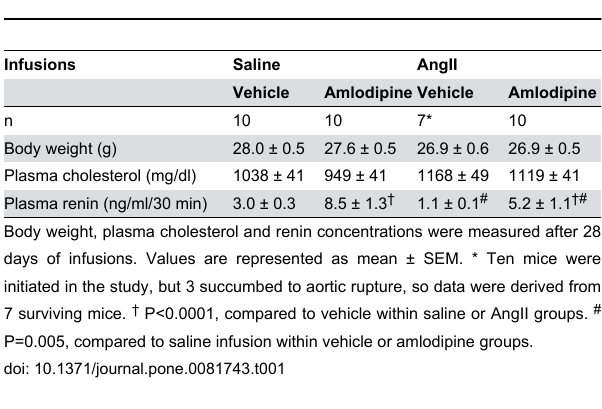
Table 1. Characteristics of study mice.